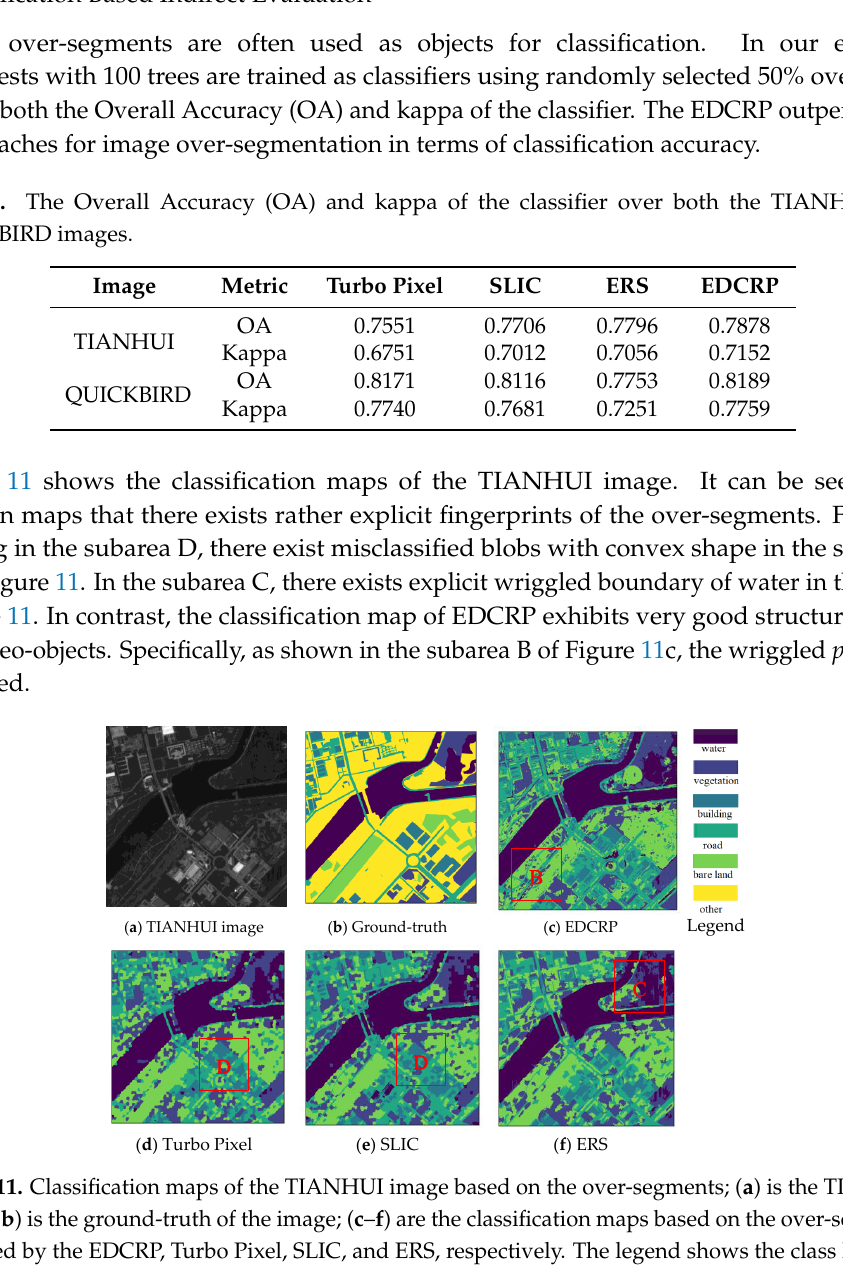
Table 4. The quantitative evaluation of different over-segmentations of QUICKBIRD image.